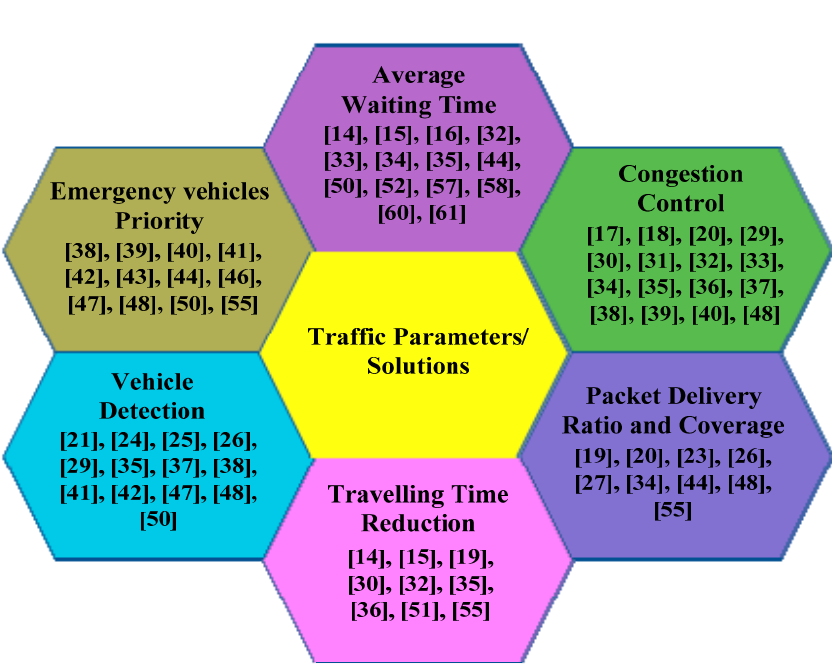
Figure 12. Fuzzy logic based multi controller system [61].